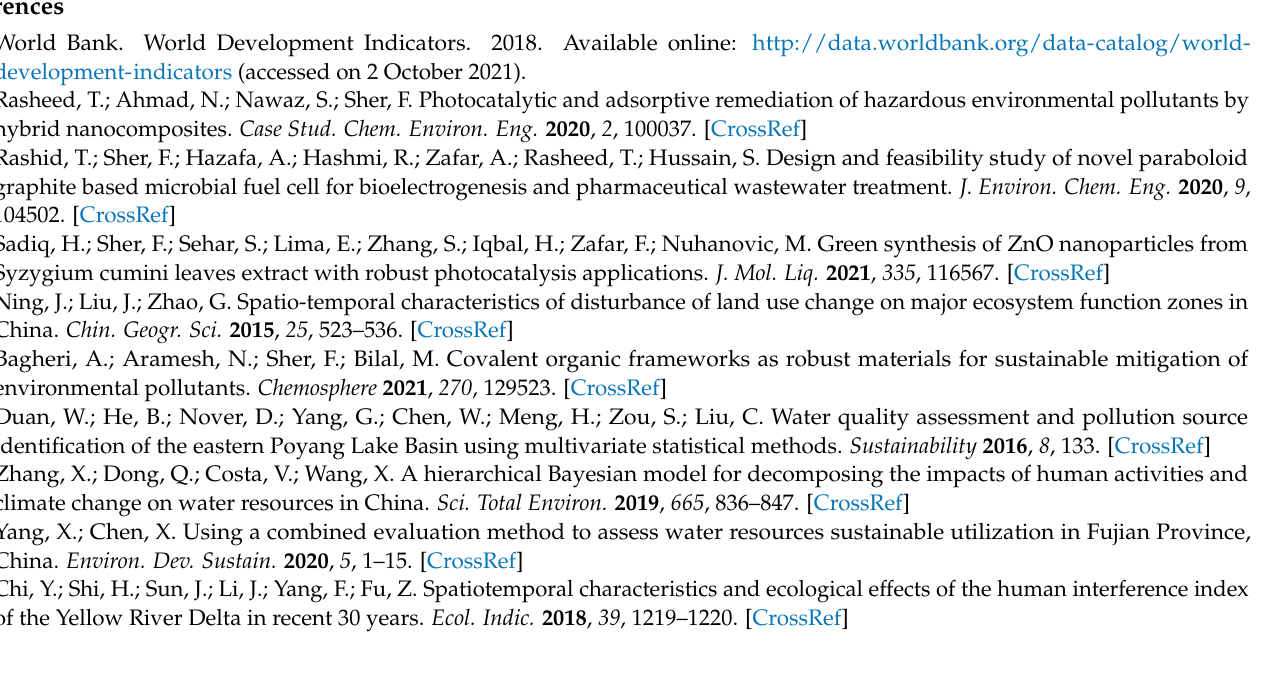
Hemeroby index. Table S2: Abbreviation, unit, grading standard, and determination method of 15 hydrochemical indices. Table S3: Anthropogenic interference levels including hemoroby index, completely disturbed, and completely disturbed proportion in different watersheds and